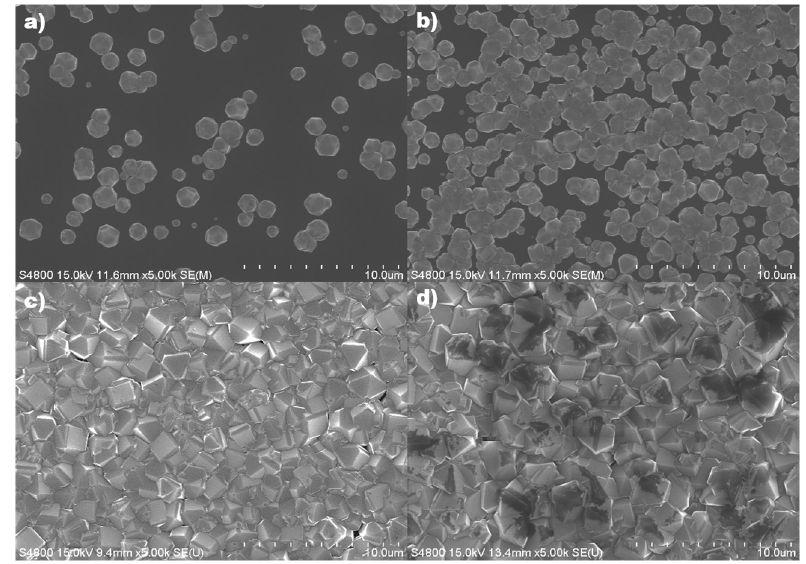
Figure 5. Surface morphologies of the diamond films deposited at powers of ( a ) 12 kW, ( b ) 14 kW, ( c ) 16 kW, and ( d ) 18 kW.